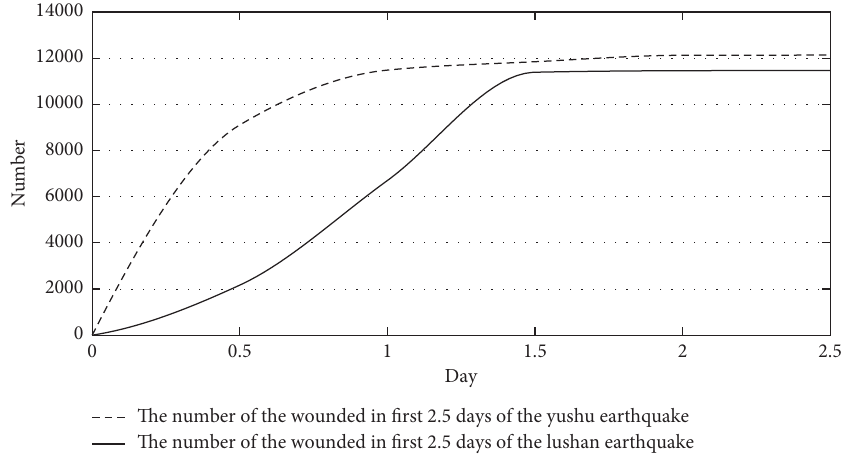
Figure 1: The number of the wounded in the early stage of